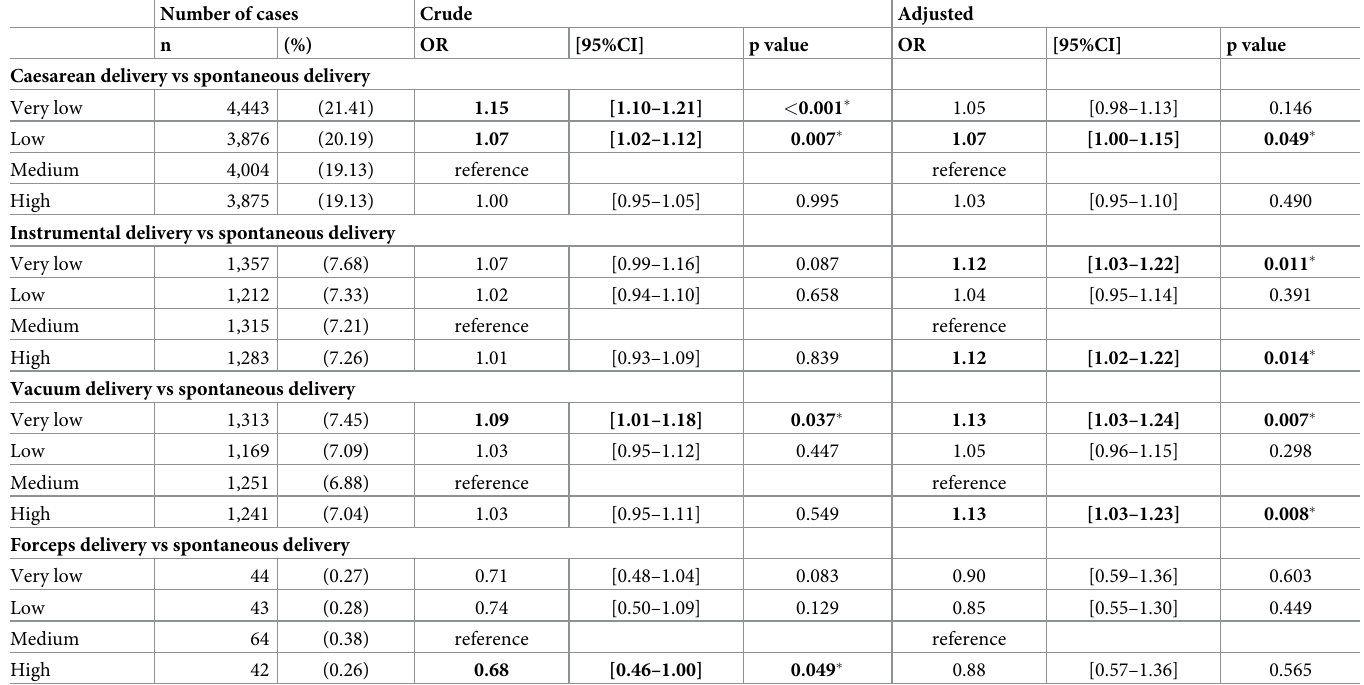
Table 4. Association between physical activity level during pregnancy and mode of